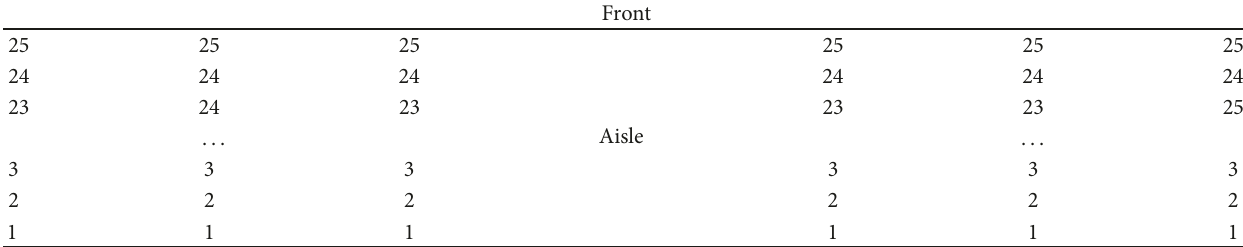
Table 2: The scheme of the BF strategy [5].